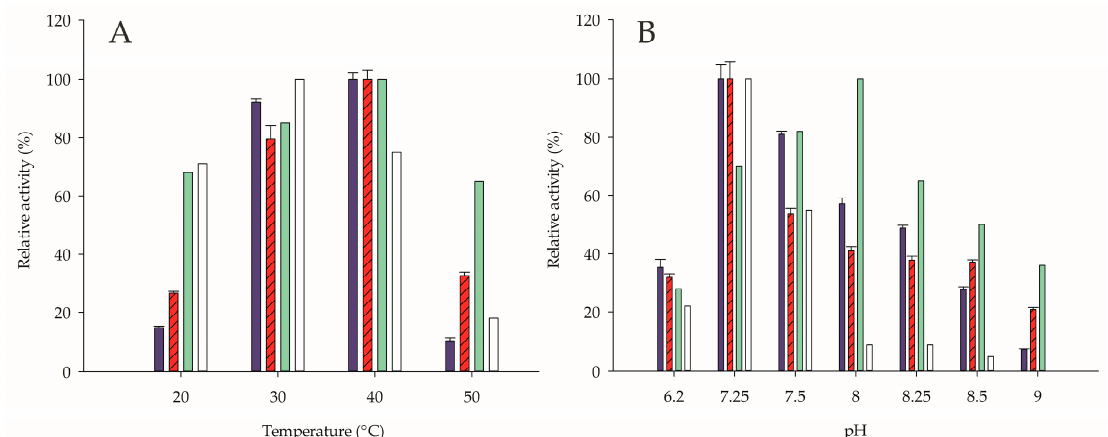
Figure 4. ( A ) E ff ect of temperature on lipolytic activity relative to the maximum value for proROL and rROL in Tris-HCl bu ff er at pH 7.25 at two di ff erent ionic strengths (200 and 400 Mm) that were taken to be 100% in each case. ( B ) E ff ect of pH on lipolytic activity relative to the maximum value for proROL and rROL in Tris-HCl bu ff er at 30 ◦ C at two di ff erent ionic strengths (200 and 400 mM) that were taken to be 100% in each case. (dark-blue) 200 mM proROL. (striped-red) 400 mM proROL. (green) 200 mM rROL. (White) 400 mM